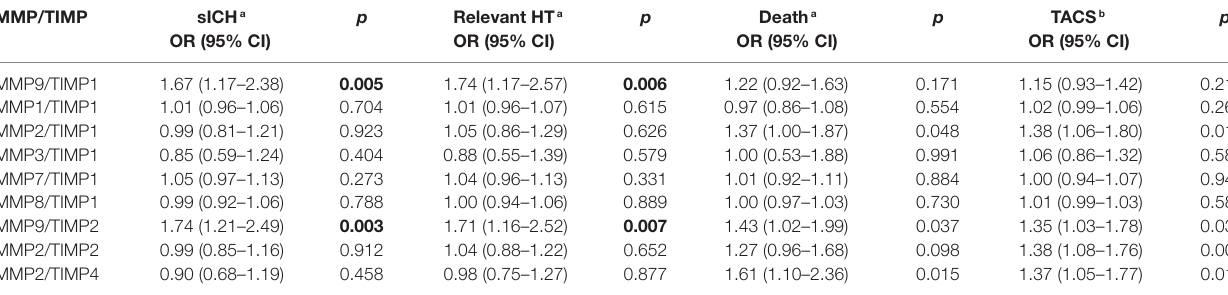
Bold font indicates statistically significant data. MMP, matrix metalloproteinase; TIMP, tissue inhibitors of metalloproteinase; OR, odds ratio; CI, confidence interval; sICH, symptomatic intracerebral hemorrhage; relevant HT, relevant hemorrhagic transformation; TACS, total anterior circulation syndrome. a Binary logistic regression analysis adjustment for age, sex, onset-to-treatment time, baseline blood glucose, baseline NIHSS, history of atrial fibrillation, history of congestive heart failure, center effect, history of recent infection/inflammation, statin use, aspirin use, antiplatelet use, and antihypertensive use. b Binary logistic regression analysis adjustment for age, sex, onset-to-treatment time, history of recent infection/inflammation, history of atrial fibrillation, history of hypertension, history of diabetes, history of congestive heart failure, statin use, aspirin use, other antiplatelet use, antihypertensive use, and center